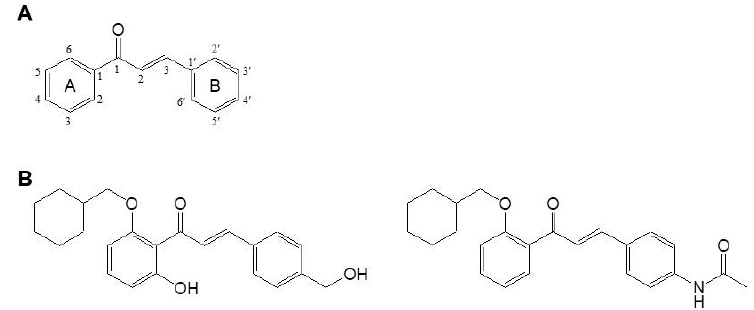
Figure 1. ( A ) Core-structure of chalcones. ( B ) Chemical structure of chalcone 21 (left) and chalcone 21-21 (right).